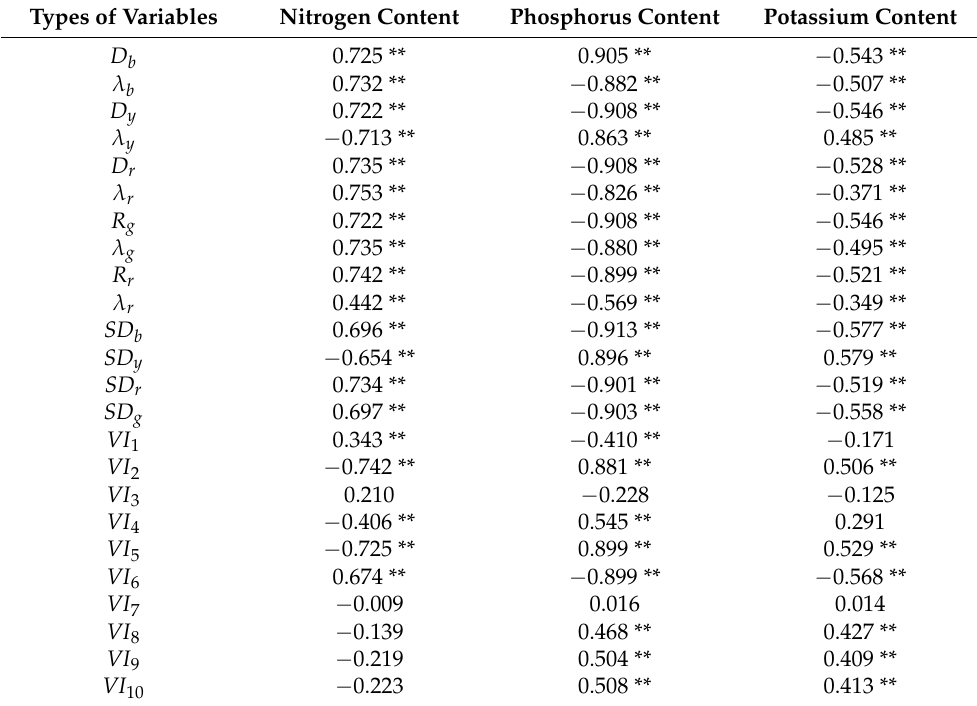
Table 2. Correlation coefficients of spectral characteristic variables with nitrogen, phosphorus and potassium